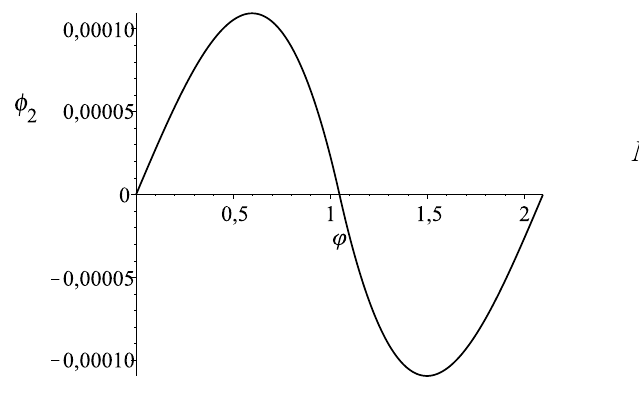
Figure 18: The graph of M = M ( φ ) .